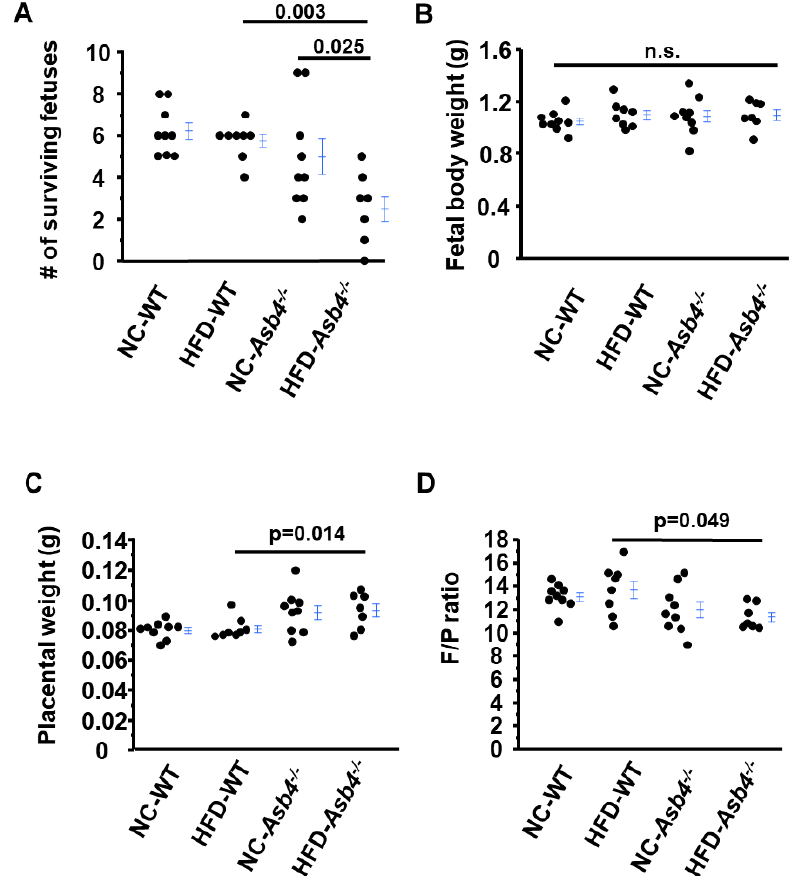
Figure 2. Asb4 −/− pregnant mice fed a high-fat diet (HFD) have decreased surviving fetuses and decreased fetal weight/placental weight ratio. WT and Asb4 −/− pregnant mice were euthanized at 18.5 days post-coitus (dpc). The number of surviving fetuses was counted, and the fetal body weight and placental weight were measured. ( A ) Average number of surviving fetuses. ( B ) Fetal body weight. ( C ) Placental weight. ( D ) Fetal body weight/placental weight (F/P) ratio. NC: normal diet; HFD: high-fat diet; n.s.: not significant. n = 9 (NC-WT), 8 (HFD-WT), 9 (NC- Asb4 −/− ), 8 (HFD- Asb4 −/− ).